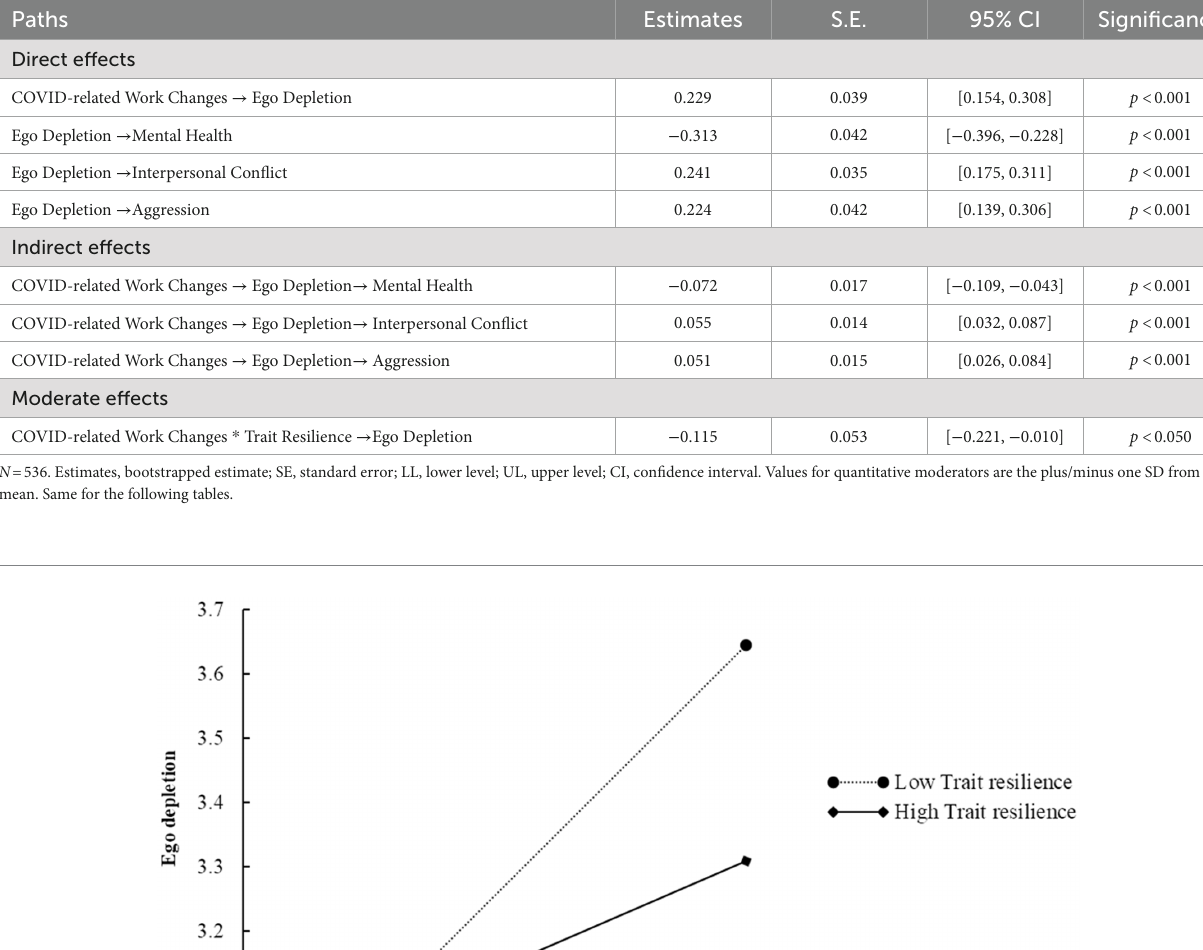
TABLE 3 Summary of direct, indirect, and interaction